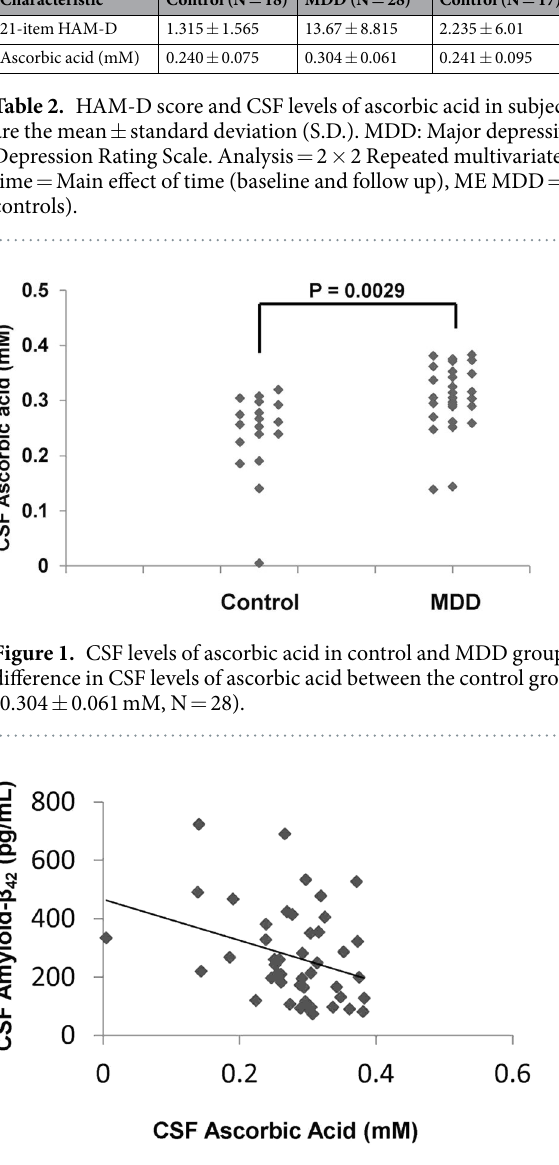
Figure 2. Correlations between CSF ascorbic acid and CSF amyloid- β 42 . There was a significant negative correlation (r = − 0.31, P = 0.037) between CSF ascorbic acid and CSF amyloid- β 42 in the all subjects (N =